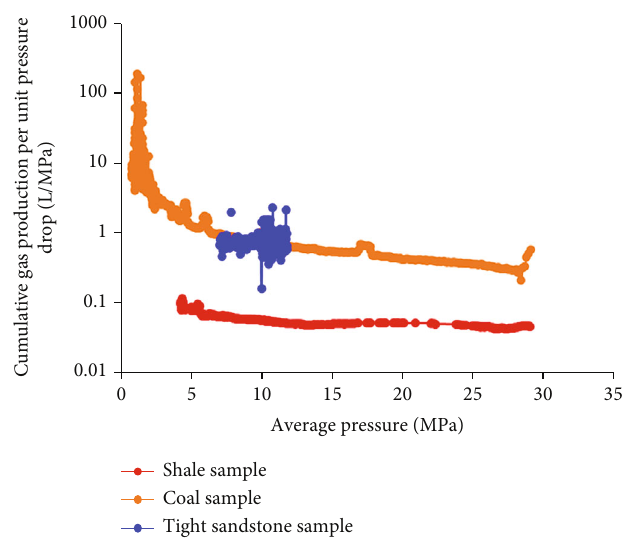
Figure 6: Comparison of gas production per unit pressure drop of three samples.